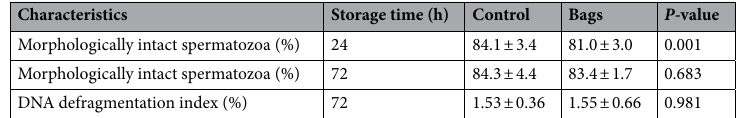
Table 2. Morphologically intact spermatozoa and DNA defragmentation index of boar spermatozoa in sixteen pooled ejaculates (4 × 4 ejaculates) from 16 mature Pietrain boars in control and MEDI NOVA bags. Values are represented as mean ±